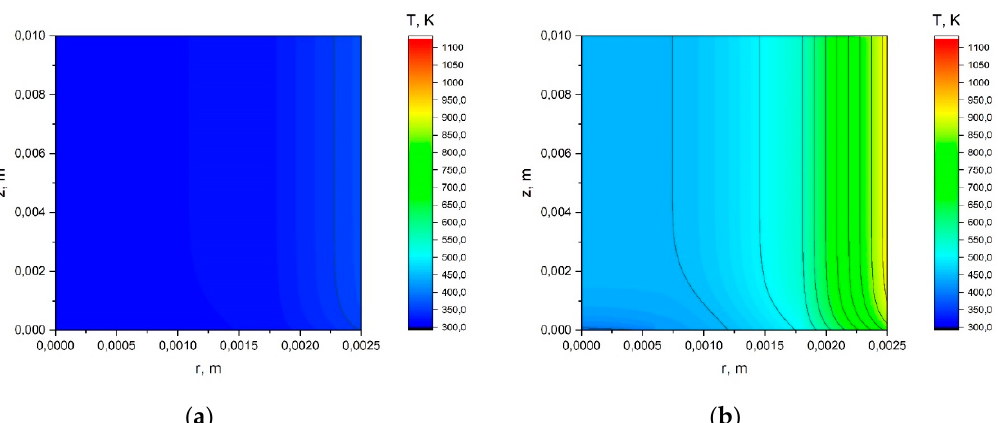
Figure A9. Temperature distribution in the stem of a herbaceous plant: R = 0.0025 m, t = 6 s, q = 3 kW/m 2 ( a ); R = 0.0025 m, t = 6 s, q = 30 kW/m 2 ( b ).